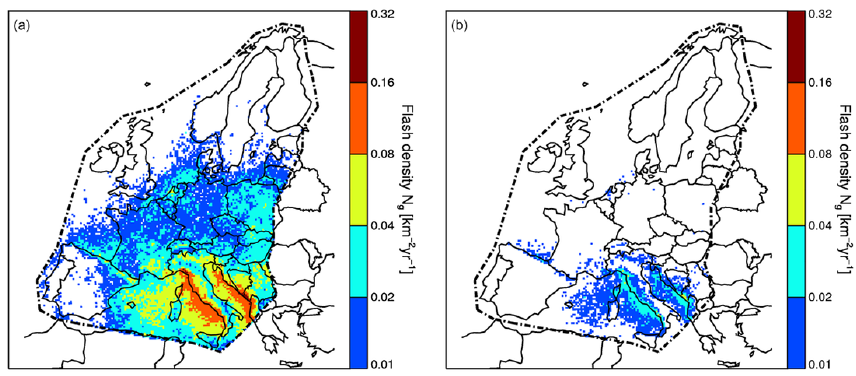
Figure 8. Mean annual flash density [km − 2 yr − 1 ] of negative CG flashes with estimated absolute peak current above (a) 75kA and (b)